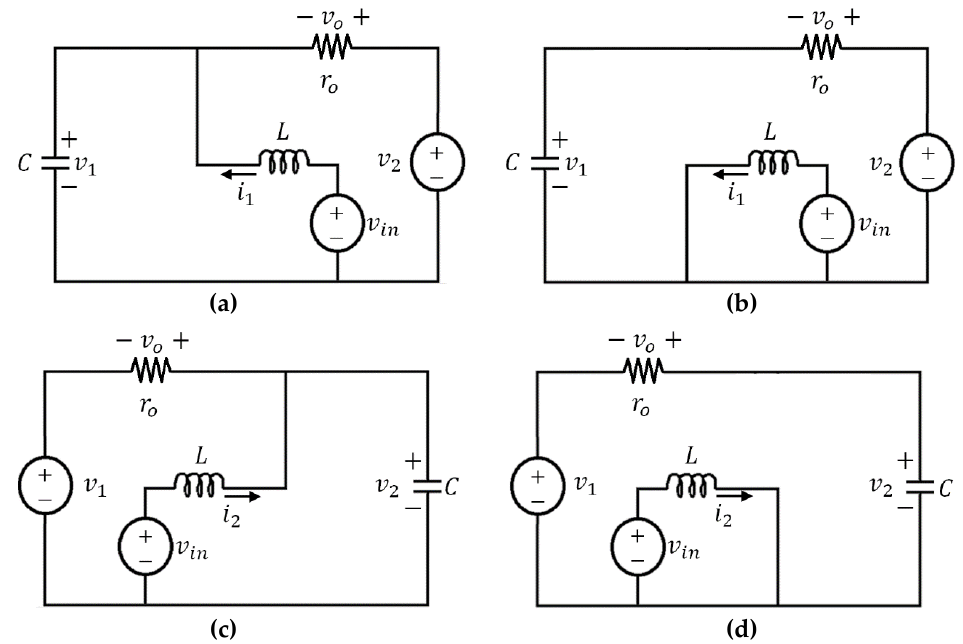
Figure 4. Circuit structures of the boost inverter operating in DS-SMC. ( a ) Cell 1 state 0, ( b ) cell 1 state 1, ( c ) cell 2 state 0 and ( d ) cell 2 state 1.